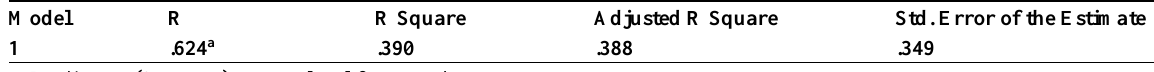
Table 5: Model Summary